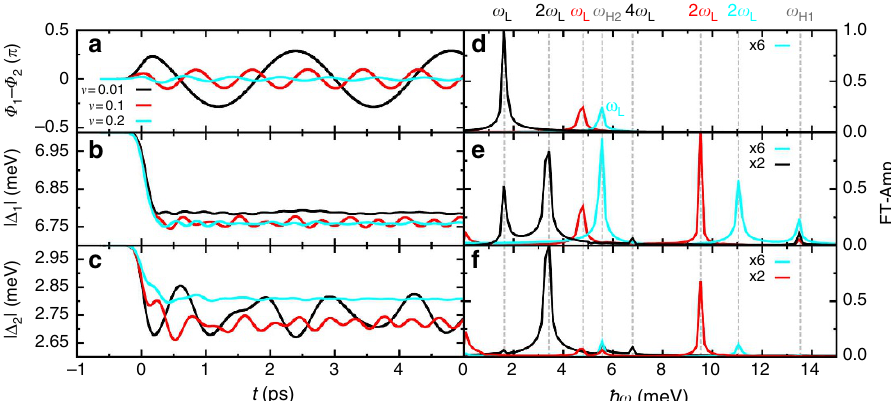
Figure 2 | Leggett phase mode and amplitude Higgs mode oscillations. Numerical simulation of the gap dynamics of a two-gap superconductor after a non-adiabatic excitation by a short intense laser pulse of width t ¼ 0.4ps, pump energy (cid:2) h o 0 ¼ 8meV and light-field amplitude | A 0 | ¼ 10 (cid:4) 10 (cid:2) 8 Js(Cm) (cid:2) 1 . ( a ) Phase difference F 1 – F 2 between the two gaps as a function of time t for various interband coupling strengths u . ( d ) Fourier spectrum of the oscillations in a . The frequency of the non-equilibrium Leggett mode oscillation is indicated by o L . ( b , c ) Gap amplitudes | D 1 | and | D 2 | as a function of time t for different interband couplings u . ( e , f ) Fourier spectra of the amplitude mode oscillations in b , c , which display the following frequencies: o H1 and o H2 are the frequencies of the non-equilibrium Higgs modes of gap D 1 and D 2 , respectively; o L is the frequency of the non-equilibrium Leggett mode; and higher harmonics of the non-equilibrium Leggett mode are denoted by 2 o L and 4 o L . determined at each temporal integration step from the BCS gap equations with the attractive intraband pairing interactions V 1 and V 2 , and the interband coupling V 12 ¼ u V 1 . Motivated by the numbers for MgB 2 (ref. 42), we fix V 1 and V 2 such that the gaps in the initial state take on the values D 1 ( t i ) ¼ 7 meV and D ¼ 3 meV, and study the dynamics of the two-gap super- 2 ( t i ) conductor as a function of the relative interband coupling u . H laser represents the interaction of the pump laser with the super- conductor and contains terms linear and quadratic in the vector potential of the laser field, which is of Gaussian shape with central frequency : o 0 ¼ 8 meV, pulse width t ¼ 0.4 ps and light-field amplitude | A 0 |. We determine the dynamics of Hamiltonian (1) by means of the density matrix approach and solve the resulting equations of motion using Runge–Kutta integration (see Methods). Figure 3 | Leggett phase mode oscillations versus relative interband coupling. Fourier spectrum of the phase mode F 1 – F 2 as a function of relative interband coupling v for a two-band superconductor perturbed by the same laser pulse as in Fig. 2. The amplitude of the phase fluctuations is indicated by the colour scale with dark red and light yellow representing the highest and lowest amplitudes, respectively. The blue open circles mark the frequency of the non-equilibrium Leggett mode o L . The blue solid line represents the frequency of the equilibrium Leggett mode described by equation (2). The dashed grey line indicates the frequency of the Higgs mode o H2 , which coincides with the boundary to the continuum of Bogoliubov quasiparticle excitations, given by twice the asymptotic gap value of the second band 2 D 1 . The inset shows a zoom-in of the blue frame 2 in the main The Hamiltonian describing the two-band superconductor coupled to the pump laser field is given by H ¼ H BCS þ H laser , with the two-band Bardeen-Cooper-Schrieffer (BCS) mean-field Hamiltonian